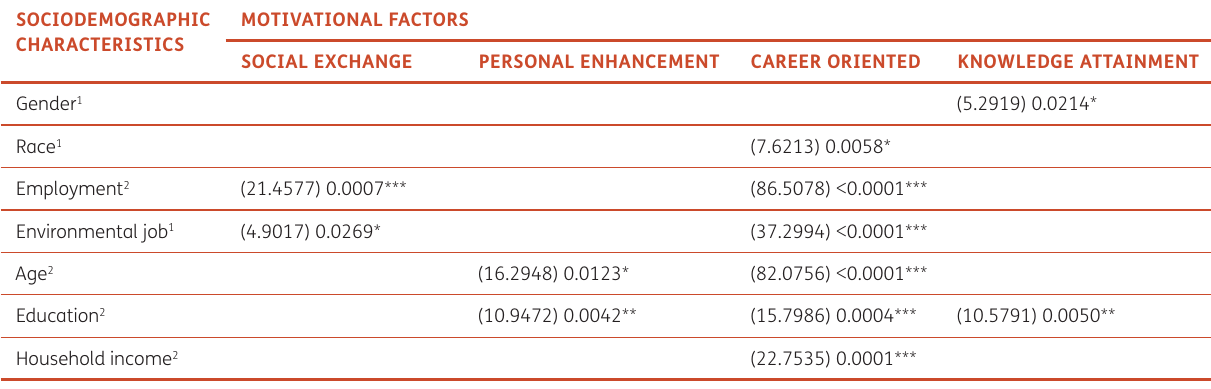
Table 4 Nonparametric results of sociodemographic characteristics and motivational factors analyses (H1). 1 Results of Mann-Whitney or 2 Kruskal-Wallis tests, dependent on the number of group variables in each test. Motivational factors (category means, see Table 3) are the measurement variable. Test statistics are denoted in parentheses and p-values are below; *, **, and *** denote statistical significance of p < .05, .01, and .001, respectively. Significant results reported only; political views and values expression were not significantly associated with any group or measurement variable and are not included in this